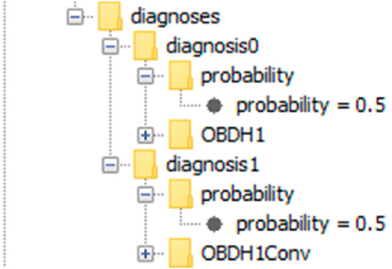
Figure 27. The two diagnoses contained in the diagnosis.xml-file. The first diagnosis is the malfunction of OBDH1 and the second diagnosis is the malfunction of OBDH1Conv. Both diagnoses have the same probability (probability = 0.5), because OBDH1 and OBDH1Conv have the same a priori failure probability (modeled in the component class definitions) and both can explain all observed discrepancies.